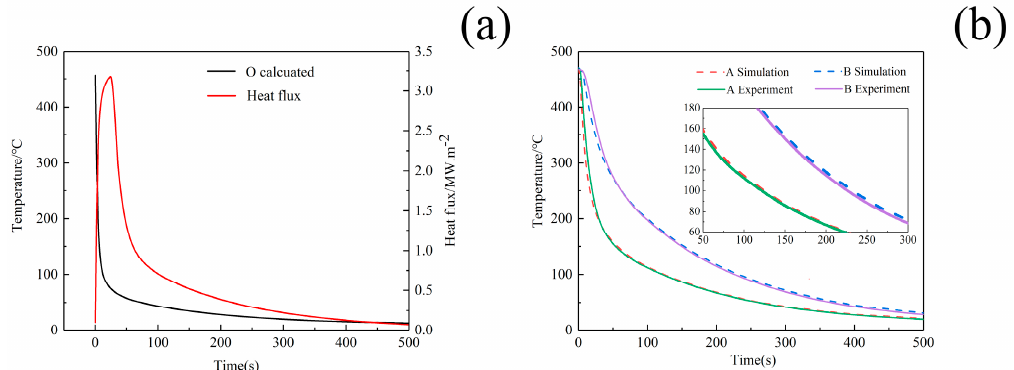
Figure 5. ( a ) Cooling curves and heat flux of surface in cylinder sample; ( b ) Comparison between simulated and experimental cooling curves of the point A and B during end-quench test when 10 °C water is adopted as quenchant.